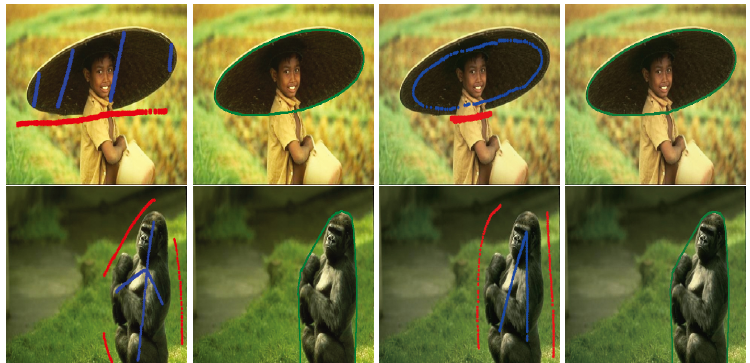
Figure 6. The robustness tests of different initial contours on our image segmentation methods with some original images shown in Figure 2. In each row of the figure, the first two columns and the last two columns show the original images with given initial contours and our corresponding image segmentation results, respectively.